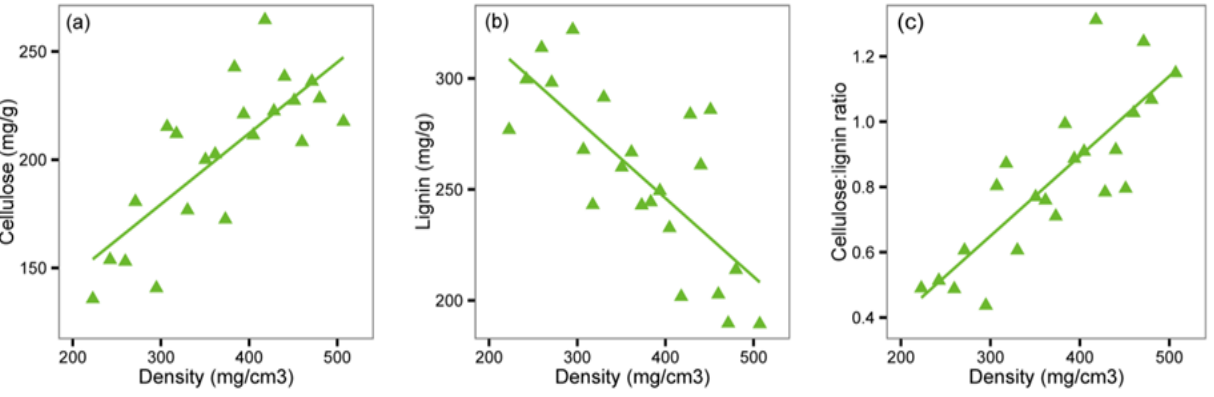
Table 3. Summary of statistics of linear models for flammability variables of Q. robur twigs dried 72h from saturation with cellulose: lignin ratio, density and diameter as independent variables; The interaction between cellulose: lignin ratio and density was also taken into account; We chose the best model by Akaike information criterion (AIC) in a stepwise algorithm; The best model (the smallest AIC) does not include all factors, as it removed factors that do not contribute significantly to the model; For the flammability variable “sum of twig heat release”, all independent variables we described above were not included in the model with the smallest AIC, so we didn‟t present any statistics related to this variable in the